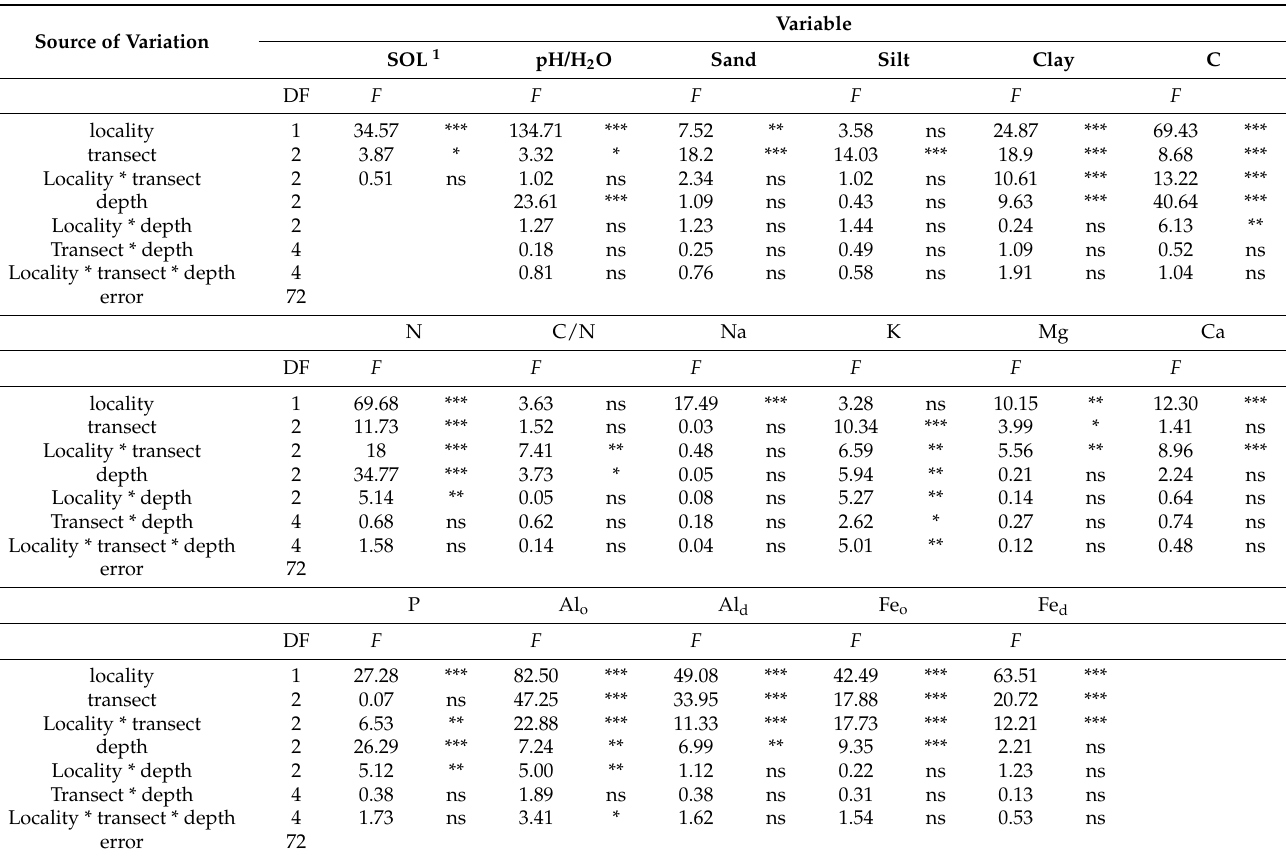
Table 3. Three-way analysis of variance of soil properties ( F -test values and corresponding signifi- cance